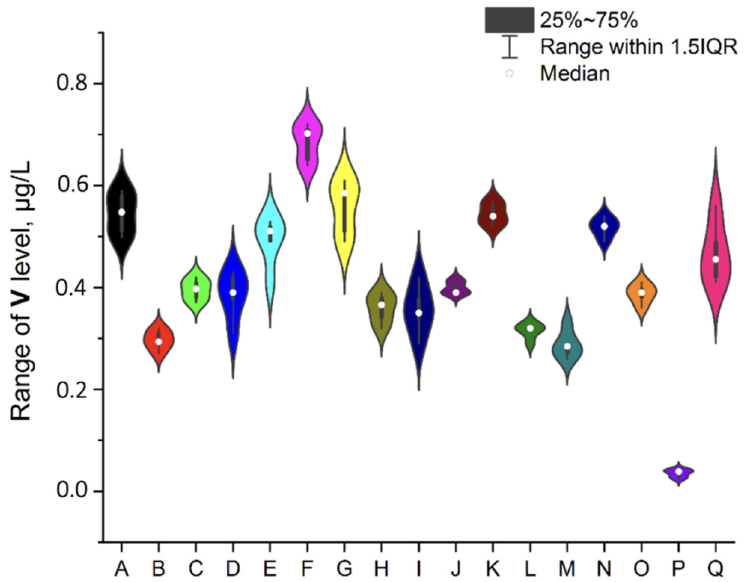
Figure 7. The plot as a violin with the box for the Sr level ( µ g/L) in the examined products (A–Q).